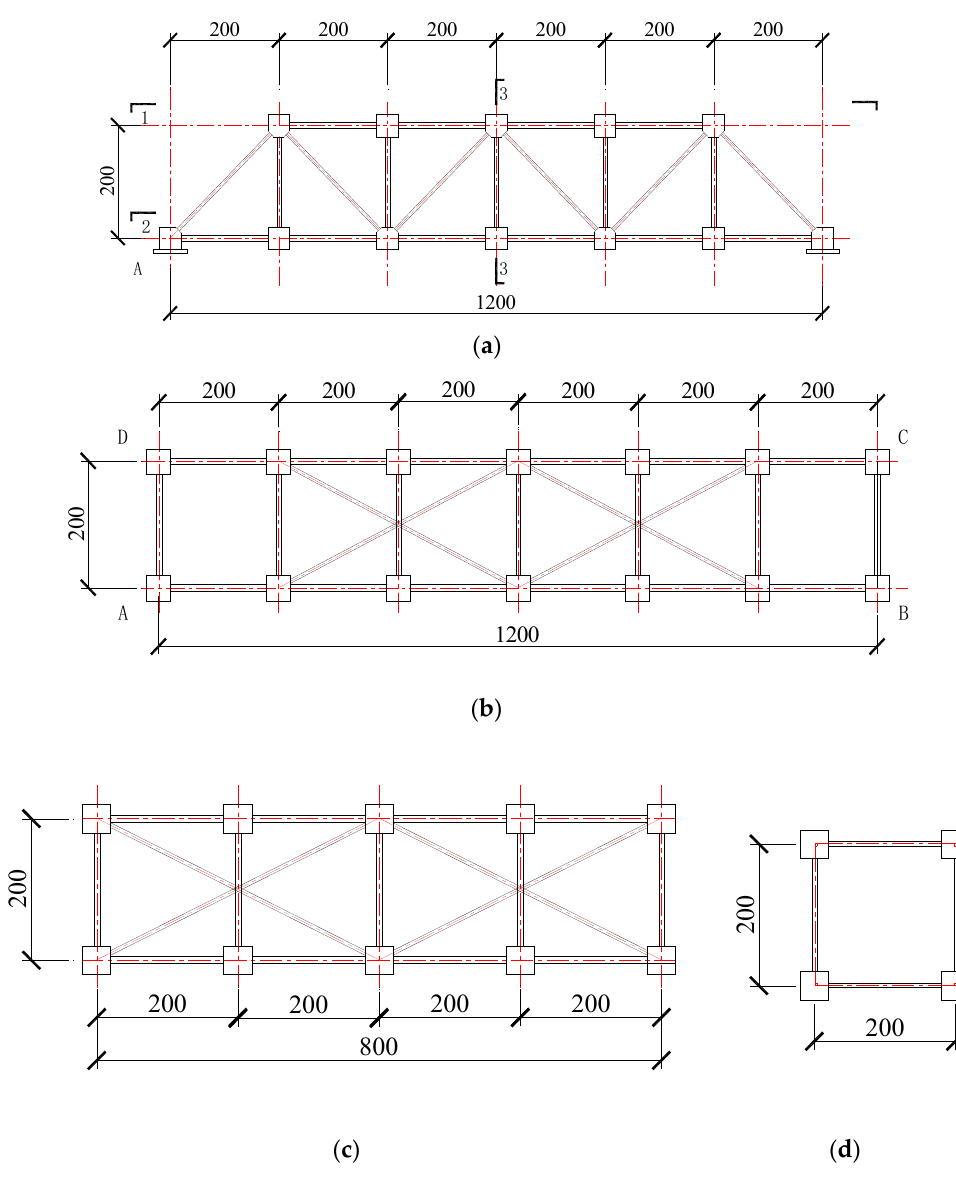
Figure 10. Magnetic stress sensing system for steel truss structures.